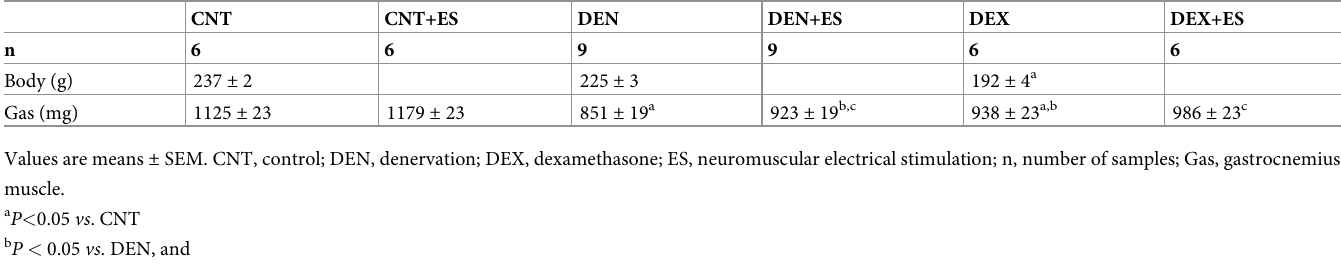
Table 1. Body and muscle weight of control, denervated, dexamethasone-treated rats.